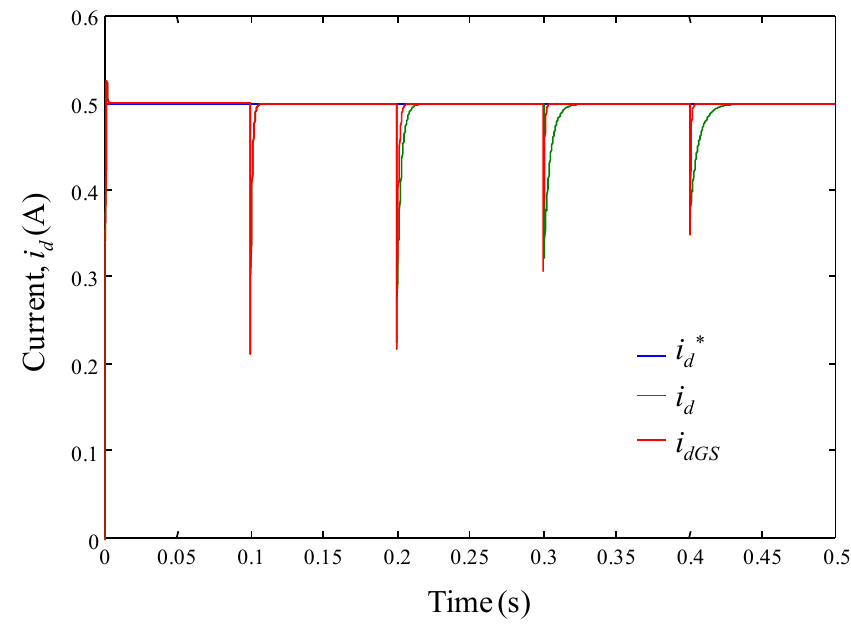
in regulation, for the two controllers, when R changes d , 2 R , 4 R , 6 R , 8 R . nom nom nom nom nom